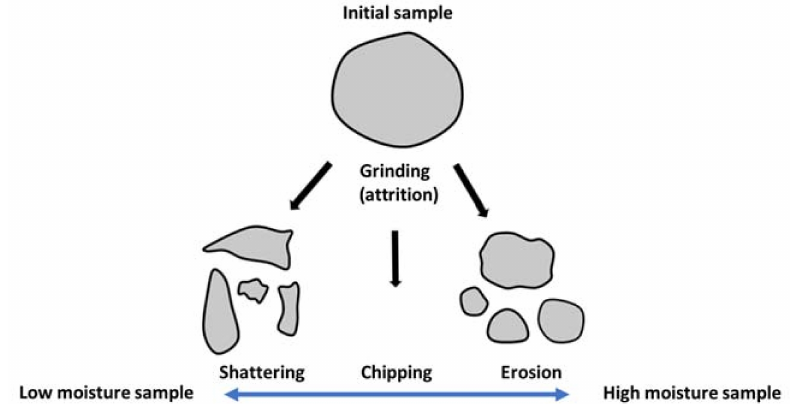
Figure 2. The main size reduction mechanisms of particle attrition and the relationship with moisture content of initial